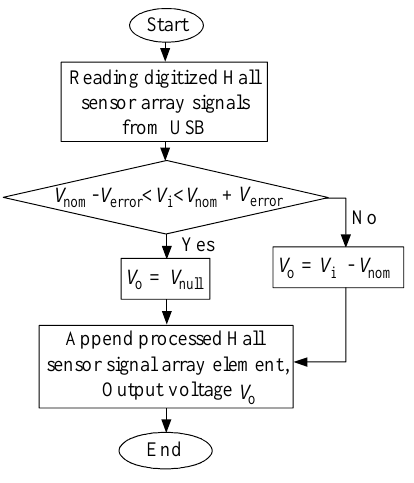
Figure 5. Flow chart of Hall sensor signal processing.